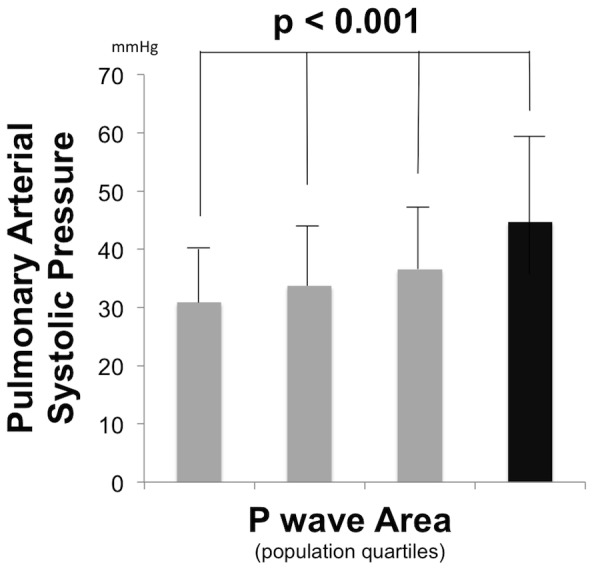
Pulmonary Arterial Pressure.Pulmonary arterial systolic pressure (mean ± standard deviation) among population subgroups stratified based on lead V1 P wave area quartiles (≤1.92 | 1.93–2.70 | 2.71–3.65 | >3.65 mV·msec). Black bar = top P wave area quartile.